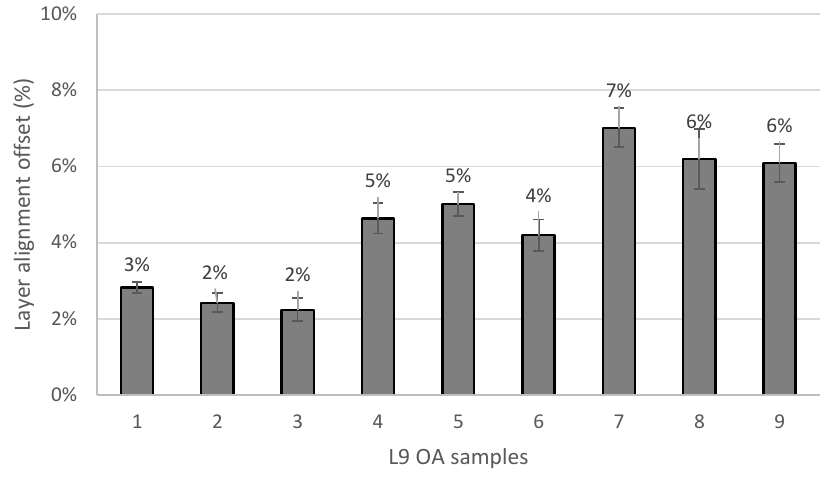
Figure 7. Layer alignment offset percentage for L9 OA.